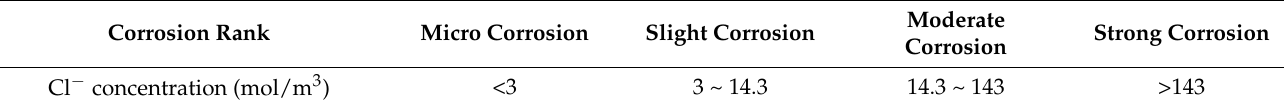
Figure 18. Cl − concentration at the cavern bottom ( − 92 m elevation) after 50 years operation: ( a )